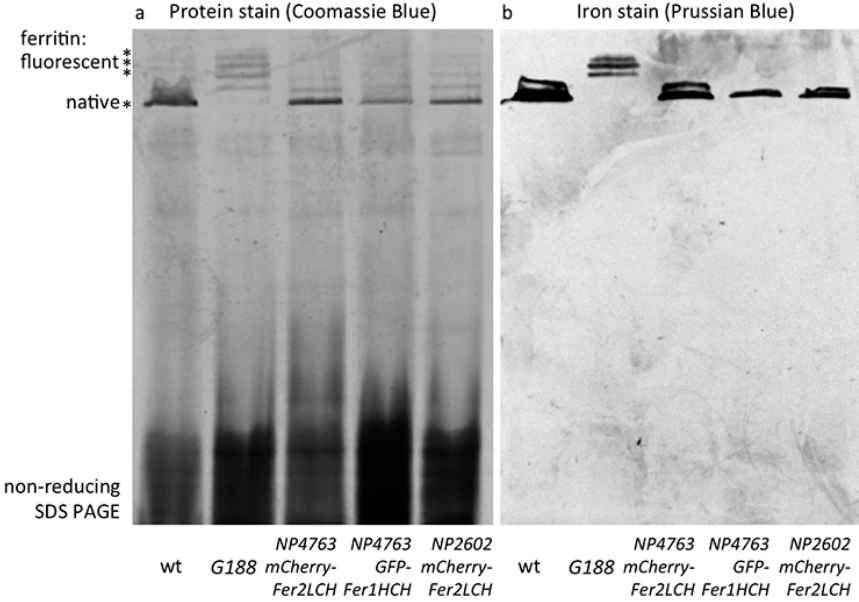
Figure 4. ( a ) Coomassie blue staining following non-reducing SDS PAGE of whole-fly homogenates of the indicated genotypes raised on 1 mM FAC supplemented food. The major high molecular weight band in these extracts (indicated by the single asterisk) is the native ferritin [15]. Higher molecular weight bands (indicated by three asterisks) represent assembled ferritin complexes with an increasing number of fluorescent protein subunits attached [21]; ( b ) Prussian blue staining to reveal iron-loaded ferritin molecules. Note that no native iron-loaded ferritin is detected in samples from Fer1HCH G188/+ fly homogenates, suggesting that in this genotype the ferritin assembly process efficiently combines GFP-Fer1HCH subunits with its endogenous Fer1HCH and Fer2LCH counterparts. In contrast, when mCherry-Fer2LCH subunit (lanes 3 and 5) or GFP-Fer1HCH subunit (lane 4) expression are driven by Fer2LCH-Gal4 , only ferritin comprised from wild type subunits is iron-loaded.